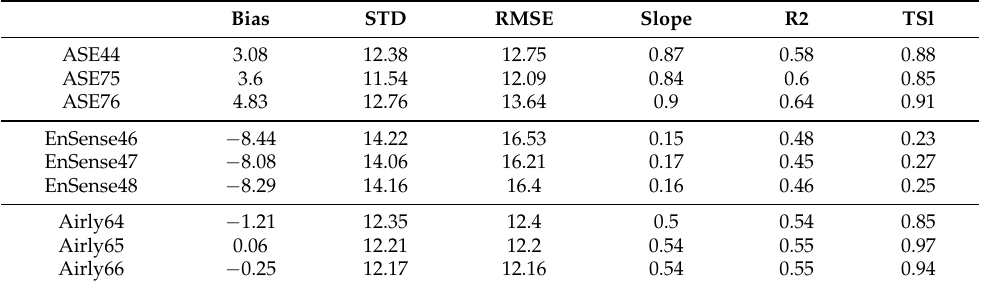
Table 2. Summary statistics of applying the sensor-specific linear regression models to the testing period at Kirkeveien. Reference instrument is Fidas and component is PM 10